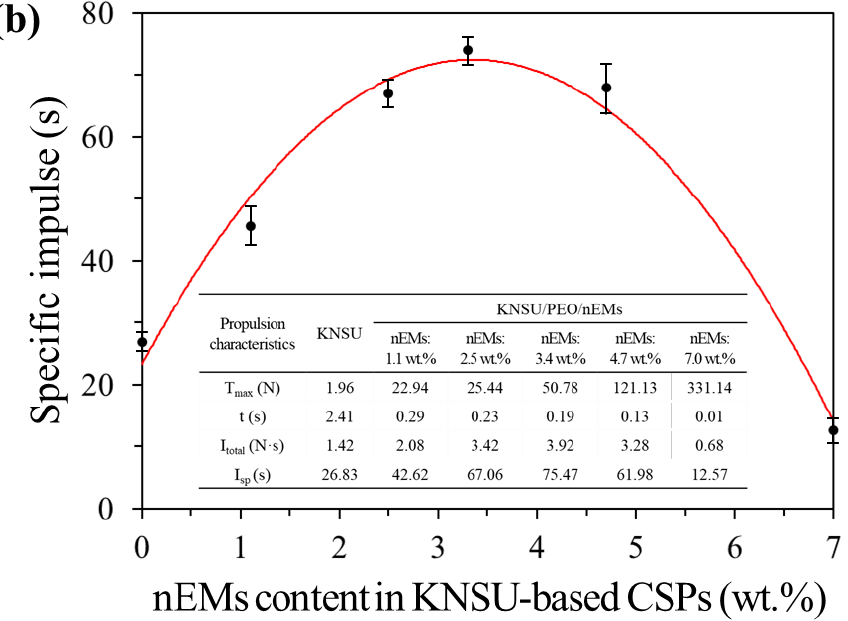
Figure 10. ( a ) Thrust traces and ( b ) specific impulses of KNSU/PEO/nEM-based 3D CSPs incorporated with various nEM contents (Inset shows the specific values of propulsion characteristics of KNSU/PEO/nEM-based 3D CSPs, where T max : maximum thrust, t: thrust duration, I total : total impulse, and I sp : specific impulse).